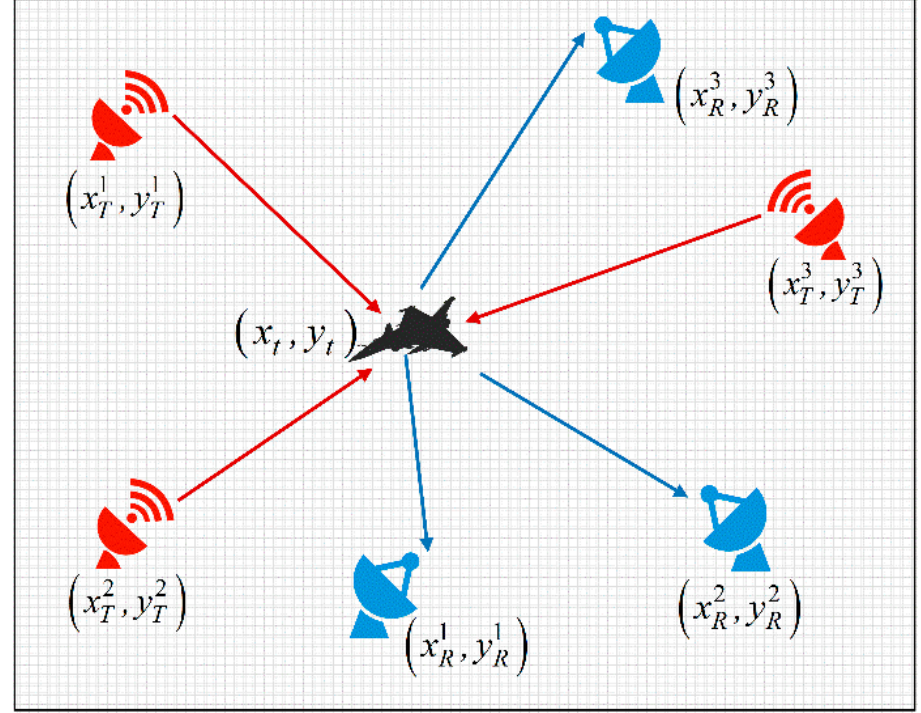
Figure 1. System configuration for distributed MIMO radar network.